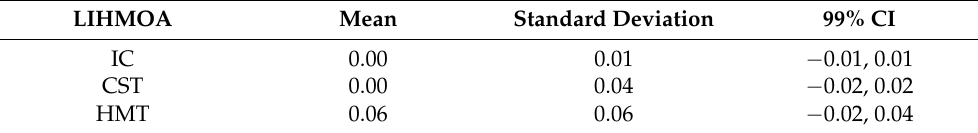
Table 3. Lateralization Index of IC, CST and HMT calculated on the basis of HMOA values. LIHMOA